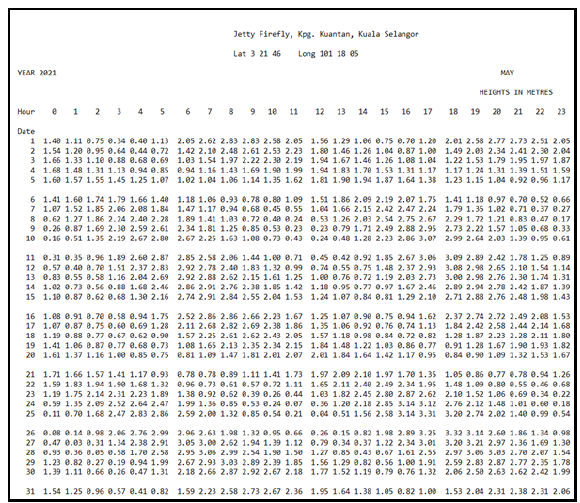
Table 6. Tide Table for May 2021 produced using TOTIS